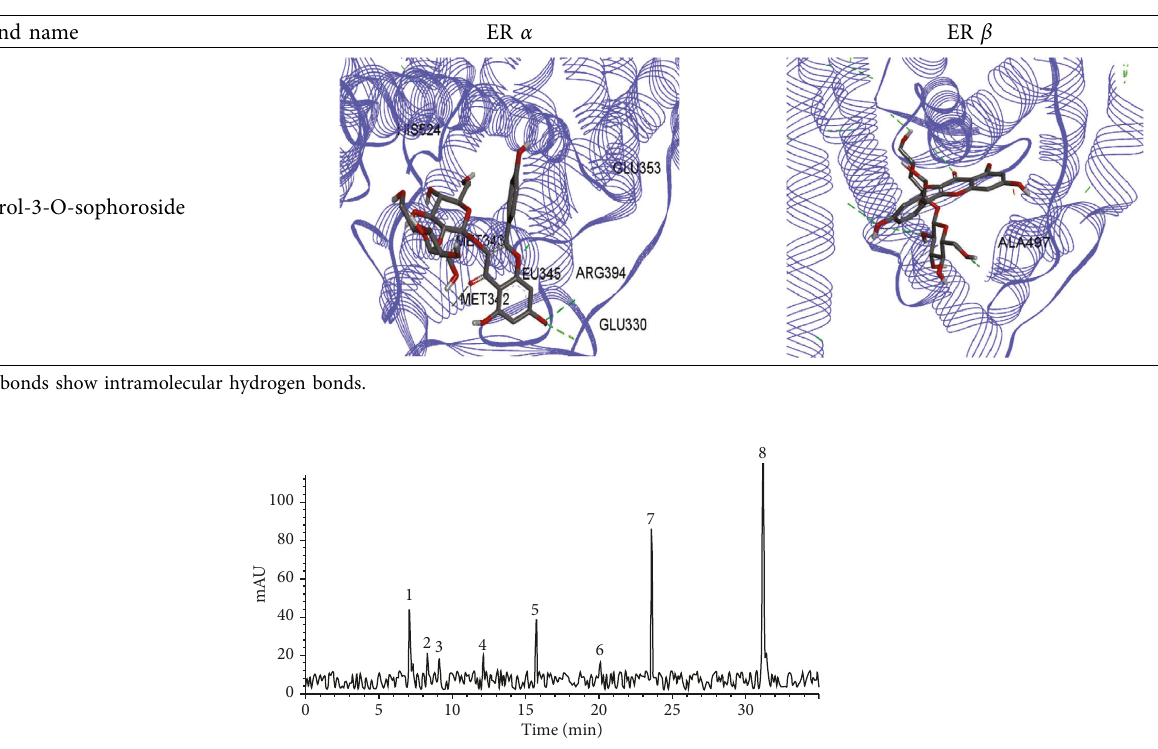
Figure 4: LC/MS analysis of the root of Astragalus microcephalus . Eight flavonoid glycosides were detected by LC/MS.